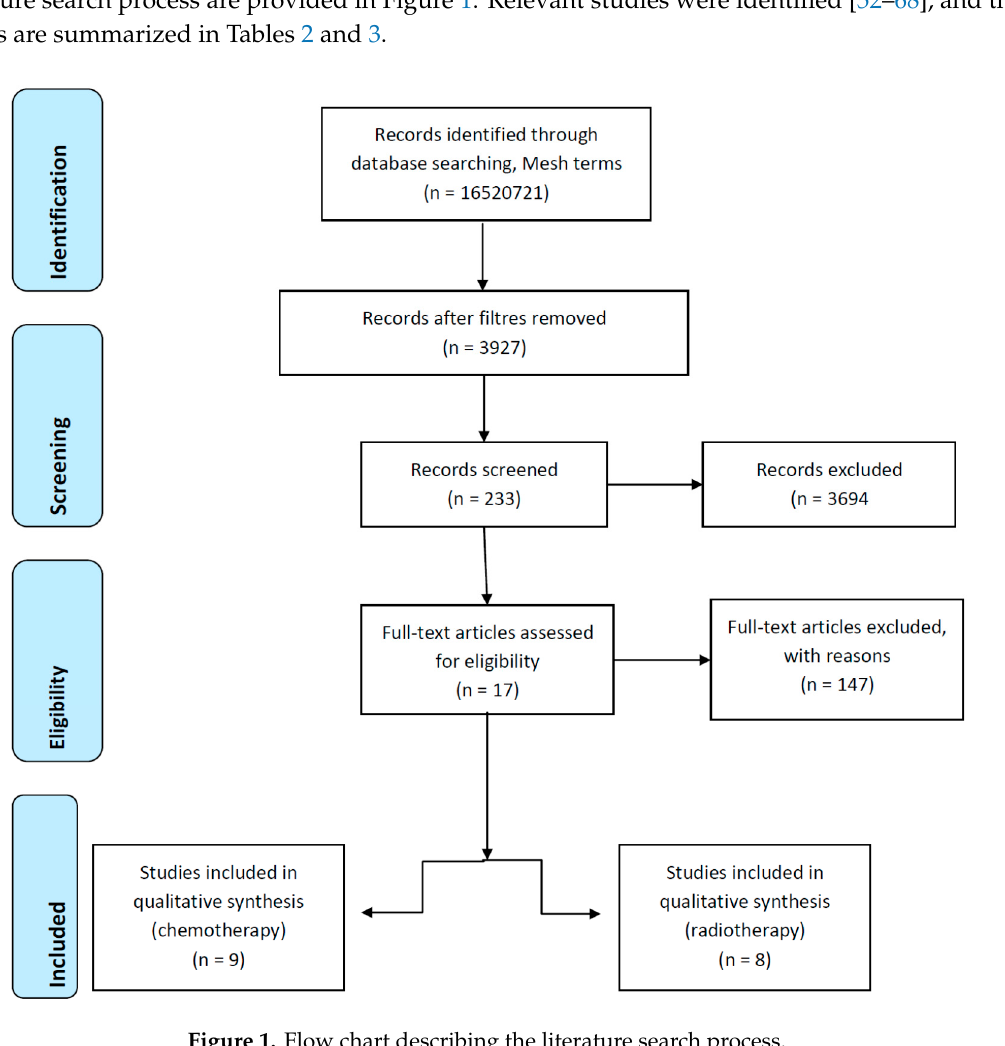
Figure 1. Flow chart describing the literature search process.